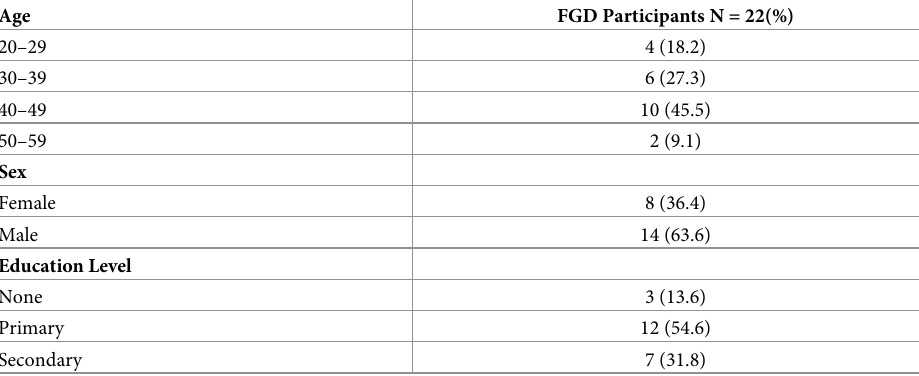
Table 2. FGDs participants